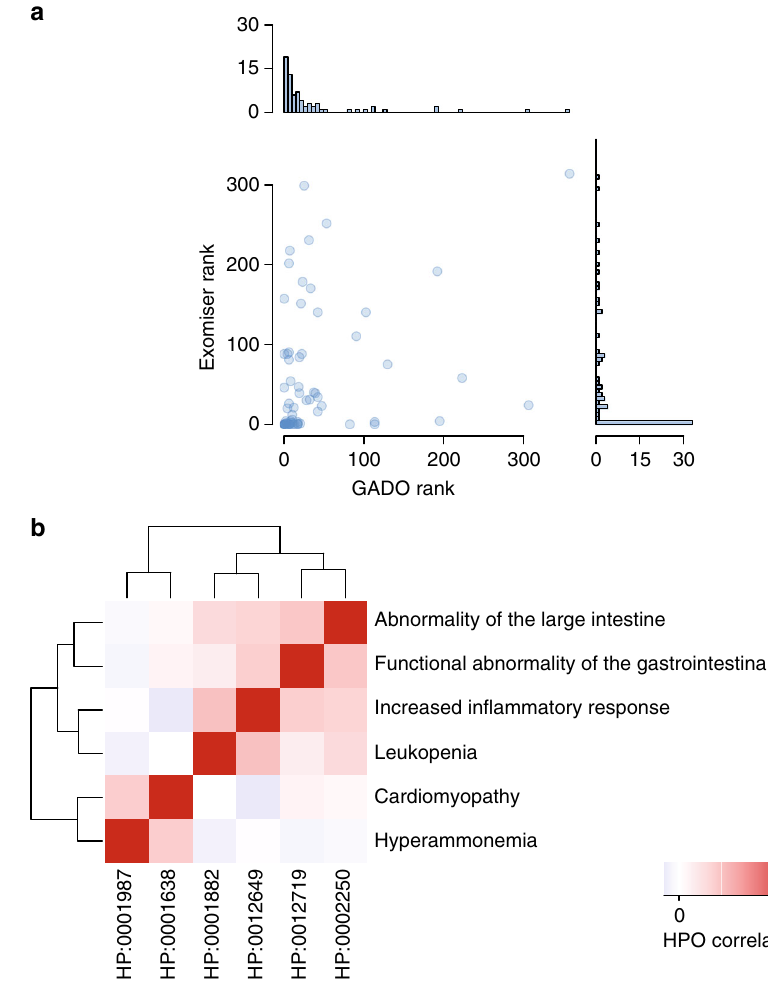
Fig. 4 Performance of GeneNetwork on solved cases. a Comparison between using GADO and Exomiser to rank candidate variants. b Our cohort contained a case with two distinct conditions, and clustering showed the HPO terms of the same disease are closest to each other. Note, the HPO term “ In fl ammation of the large intestine ” did not yield a signi fi cant prediction pro fi le and therefore the parent terms “ Abnormality of the large intestine ” , “ Increased in fl ammatory response ” and “ Functional abnormality of the gastrointestinal tract ” were used for this